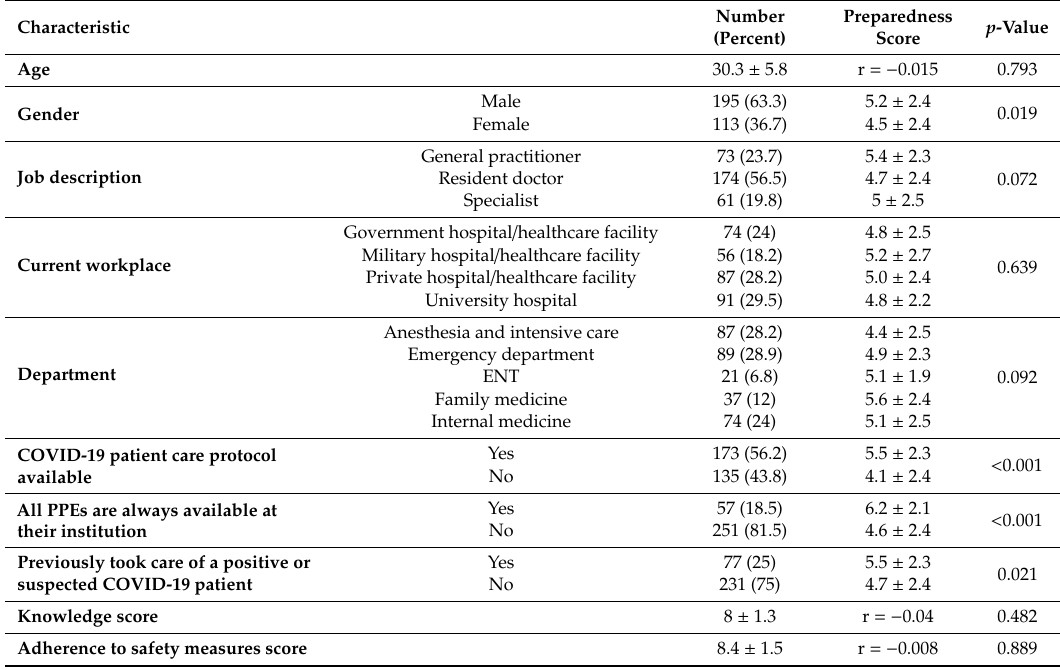
Table 3. An analysis on the e ff ect of demographic factors, knowledge score, and adherence score on the self-reported preparedness score of frontline doctors.